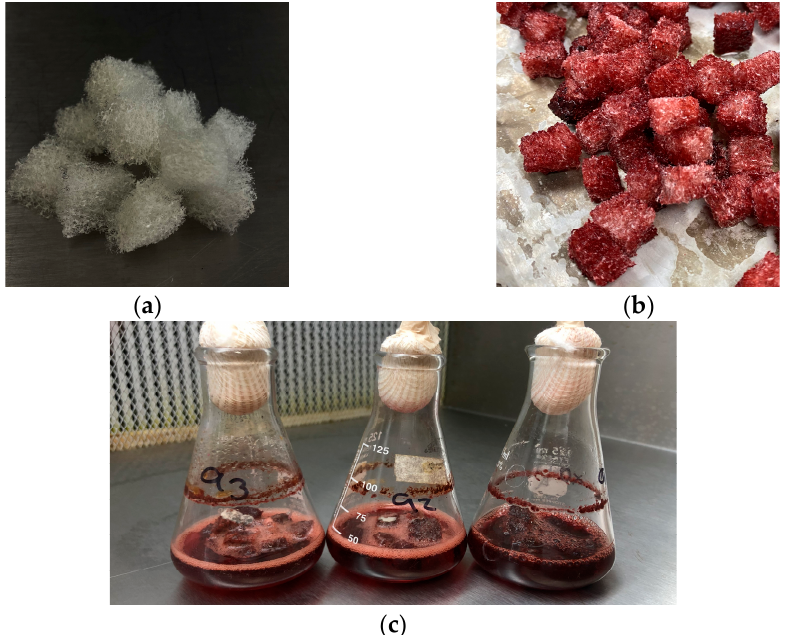
Figure 1. Selected support A. ( a ) Support A without biomass prior to fermentation; ( b ) support A with immobilized biomass after the fermentation process; ( c ) flasks with immobilization supports after fermentation.